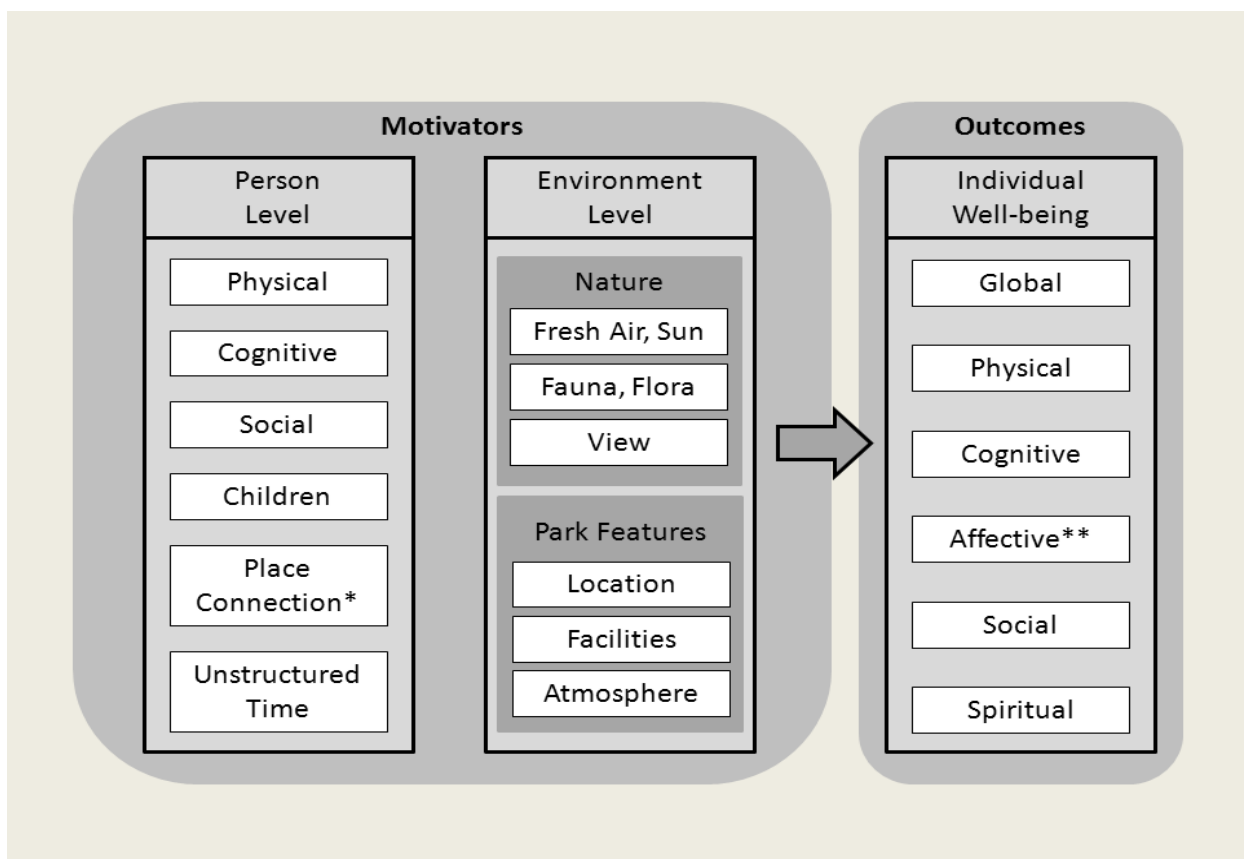
Figure 2. Measurement Model for Person-Environment-Health Relationship. The model distinguishes between the motivations for use of and the potential derived effects from interaction with the natural environment, providing a framework for measurement of